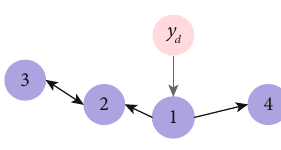
Figure 2: Communication topology for 4